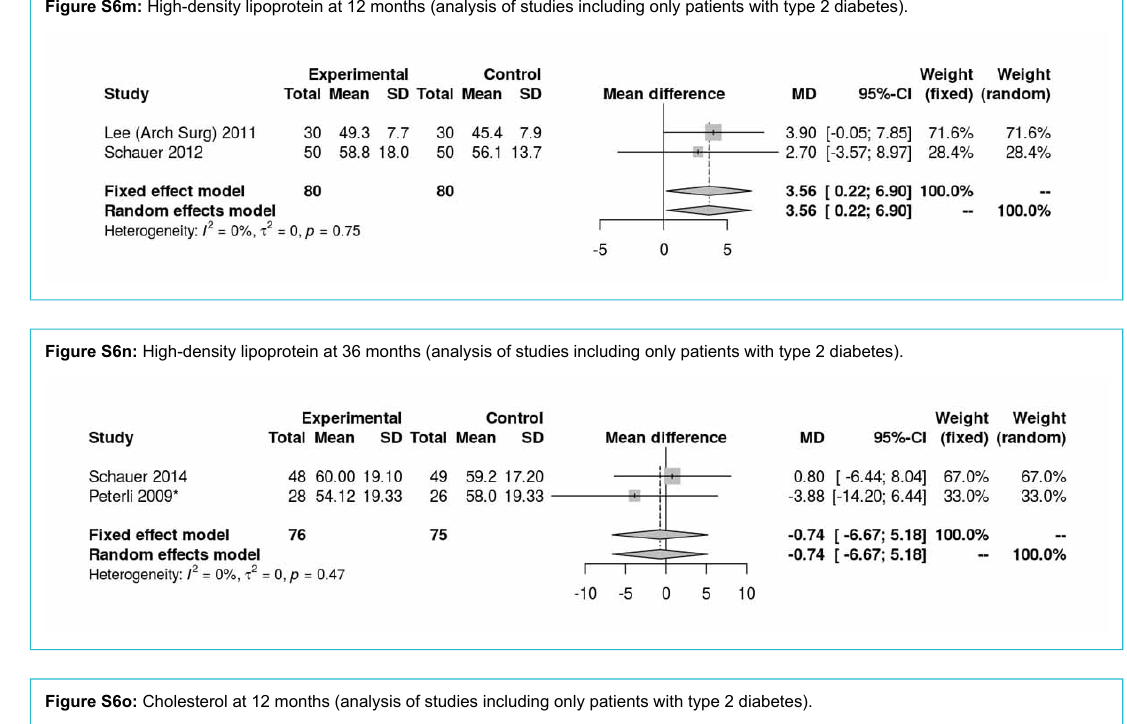
Figure S6m: High-density lipoprotein at 12 months (analysis of studies including only patients with type 2 diabetes).